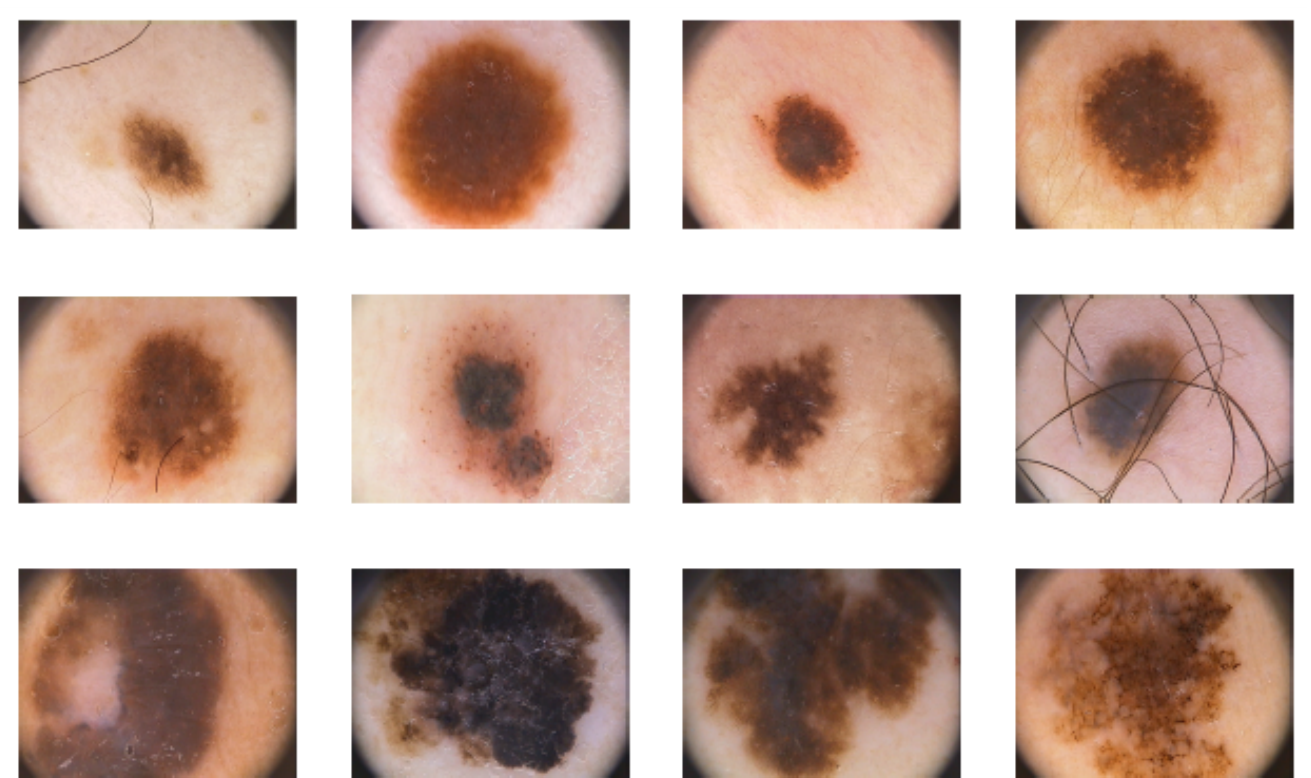
Figure 3. A graphic collection of images from the PH2 database, including common nevi (1st row), atypical nevi (2nd row), and melanomas (3rd row), https://www.fc.up.pt/addi/ph2%20database.html, accessed on 15 April